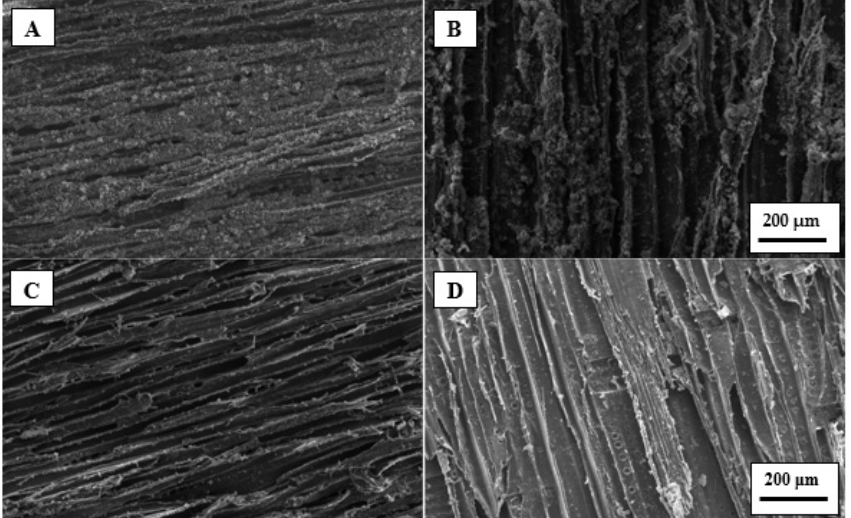
Figure 6. SEM pictures of pine wood veneers colonized by C. marina . Untreated pine wood veneers after one day of anti-biofilm assay ( A ); and after five days ( B ). Enzymatically hydrophobized pine wood veneers after one day of anti-biofilm assay ( C ); and after five days ( D ). All the pictures were acquired at 100× magnification.